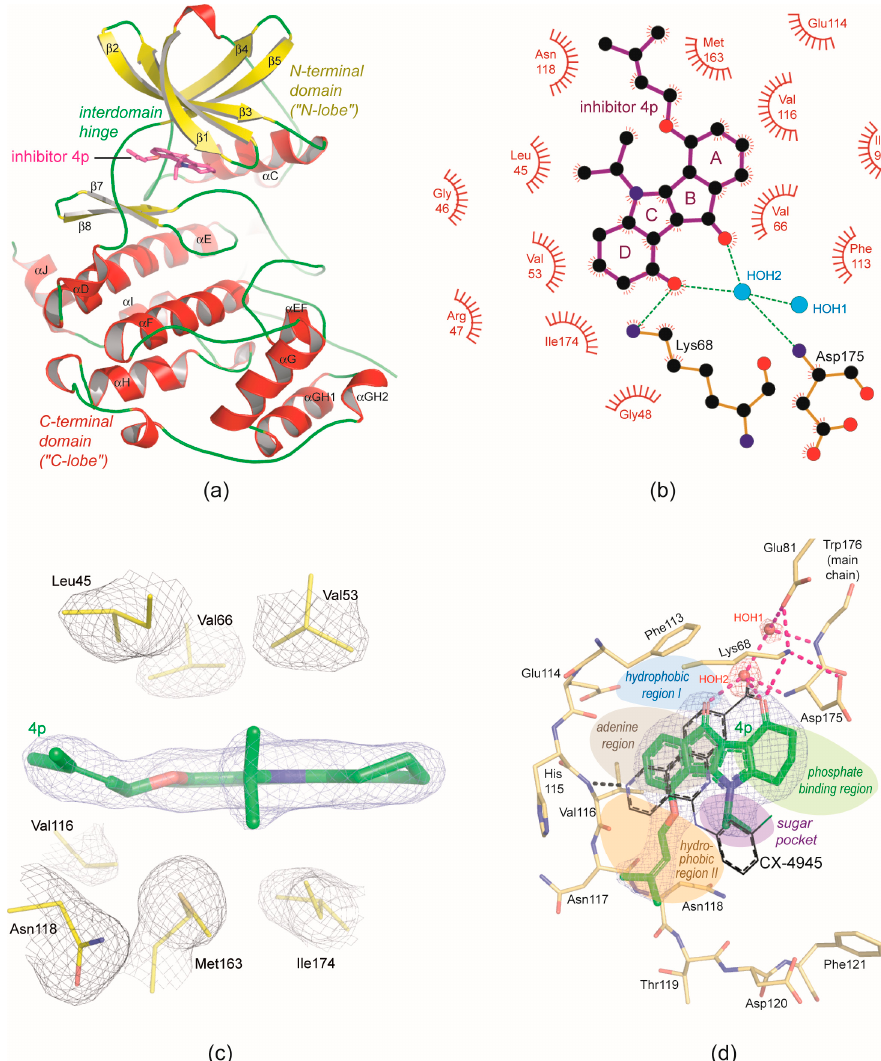
Figure 3. The principle binding mode of 4p to protein kinase CK2. ( a ) Overview of the CK2 α / 4p complex structure. ( b ) 2D-projection of the non-covalent interactions between 4p and CK2 α . ( c ) Hydrophobic packaging of 4p by non-polar side chains from the N-lobe (Leu45, Val53 and Val66), from the C-lobe (Met163 and Ile174) and from the interdomain hinge (Val116); the pieces of electron density were drawn with a cutoff level of 1 σ . ( d ) The ATP site of CK2 α with bound 4p embedded in electron density (cutoff level 1 σ ); for comparison the CK2 inhibitor CX-4945 was drawn with black C-atoms after superimposition of the protein matrices; the five regions of the ATP-site according to the protein kinase pharmacophore model of Traxler and Furet [63] are indicated by coloured patches. All parts of the figure were prepared with chain A of the low-salt CK2 α 1 − 335 / 4p structure (no. 2 of Table 1).